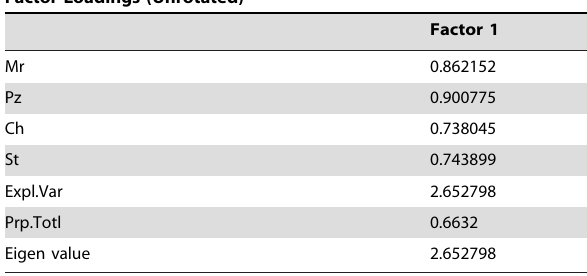
Table 1. RT Factor